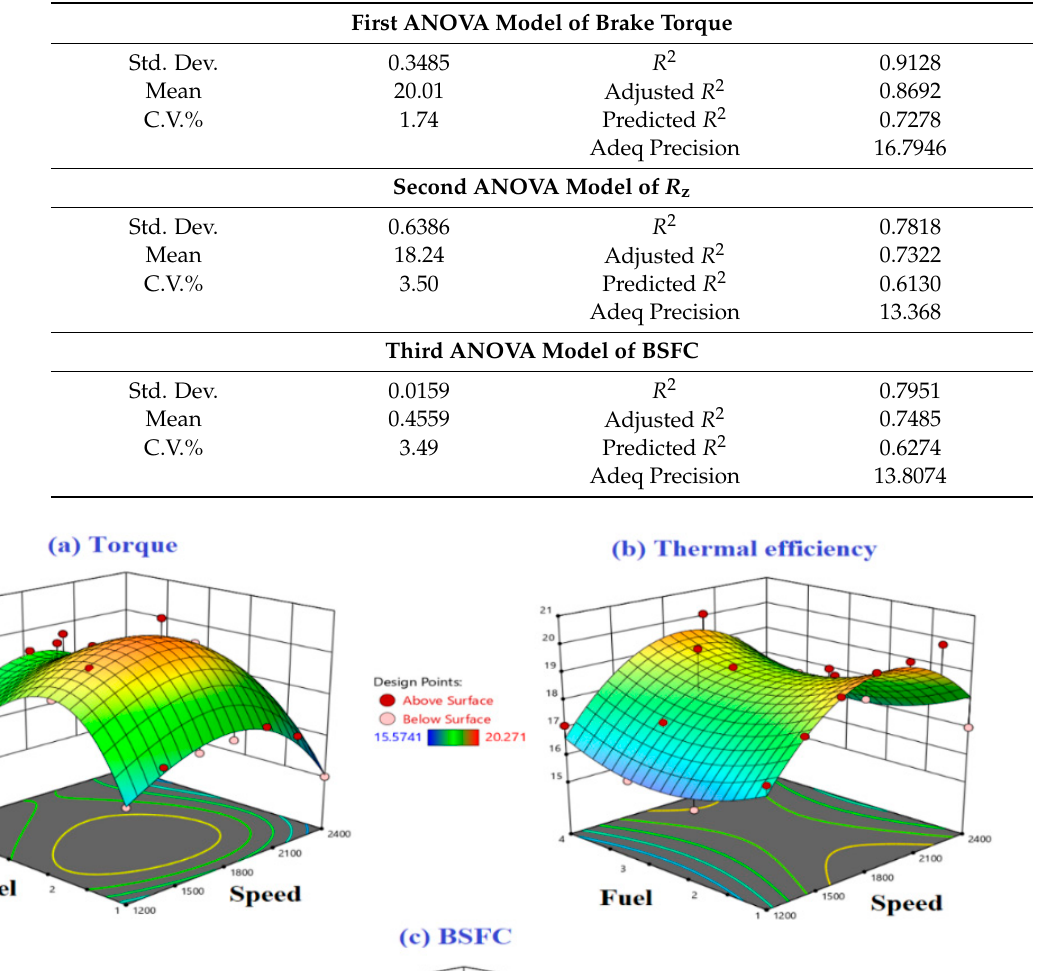
Table 11. Statistical analysis of the ANOVA model.